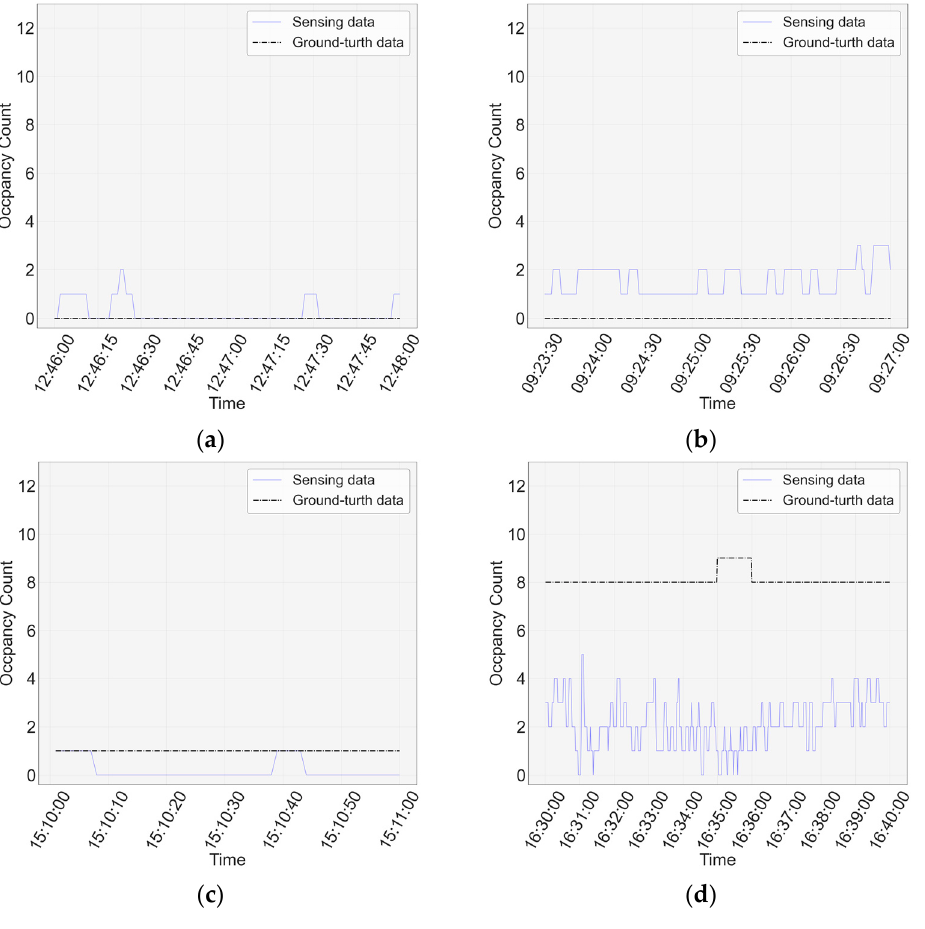
Figure 9. Classification of the occurrence of measurement errors: ( a ) case where light reflection oc- curs; ( b ) case where an object is recognized as a person; ( c ) case where a person is obscured by an object; ( d ) case where a person is obscured by a person.